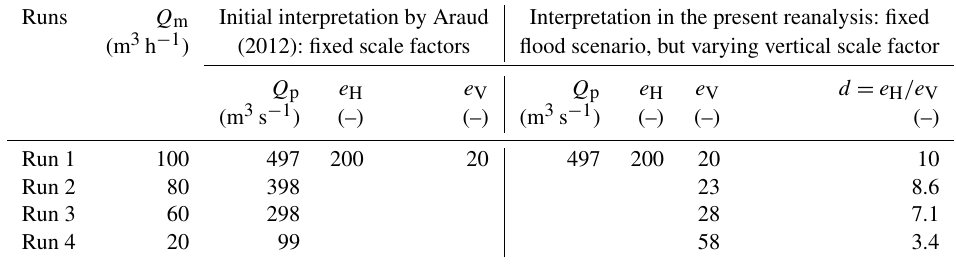
Table 2. Initial interpretation of the laboratory model runs as various flooding scenarios represented with fixed scale factors (Araud, 2012; Finaud-Guyot et al., 2018) vs. interpretation in the present reanalysis, involving a single flood scenario represented with various vertical scale factors. Notations Q m and Q p refer to the total inflow in the laboratory model and in the prototype urban district, respectively.